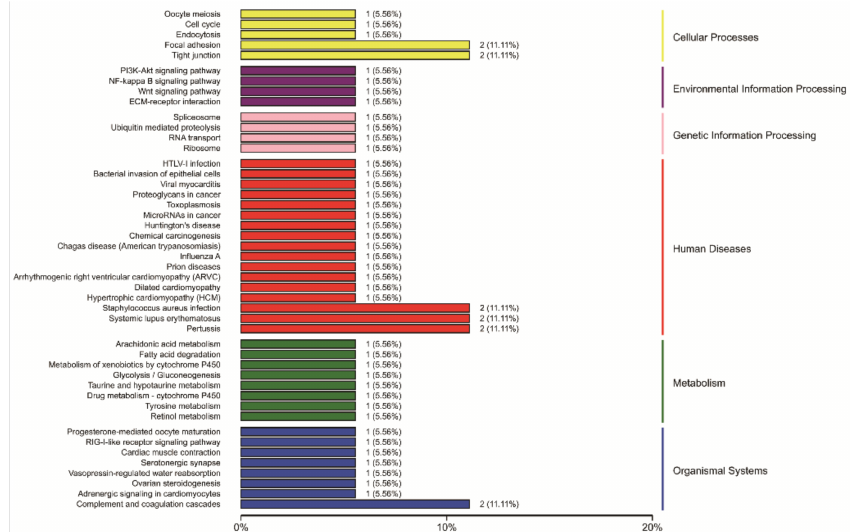
Figure 10. KEGG classification of all DEPs. For KEGG annotation, the ordinate in-dicates the name of the pathways, and the abscissa is the number and percentage of DEPs classified into the pathways. Owing to the small number of screened DEPs, few DEPs were annotated to each signaling